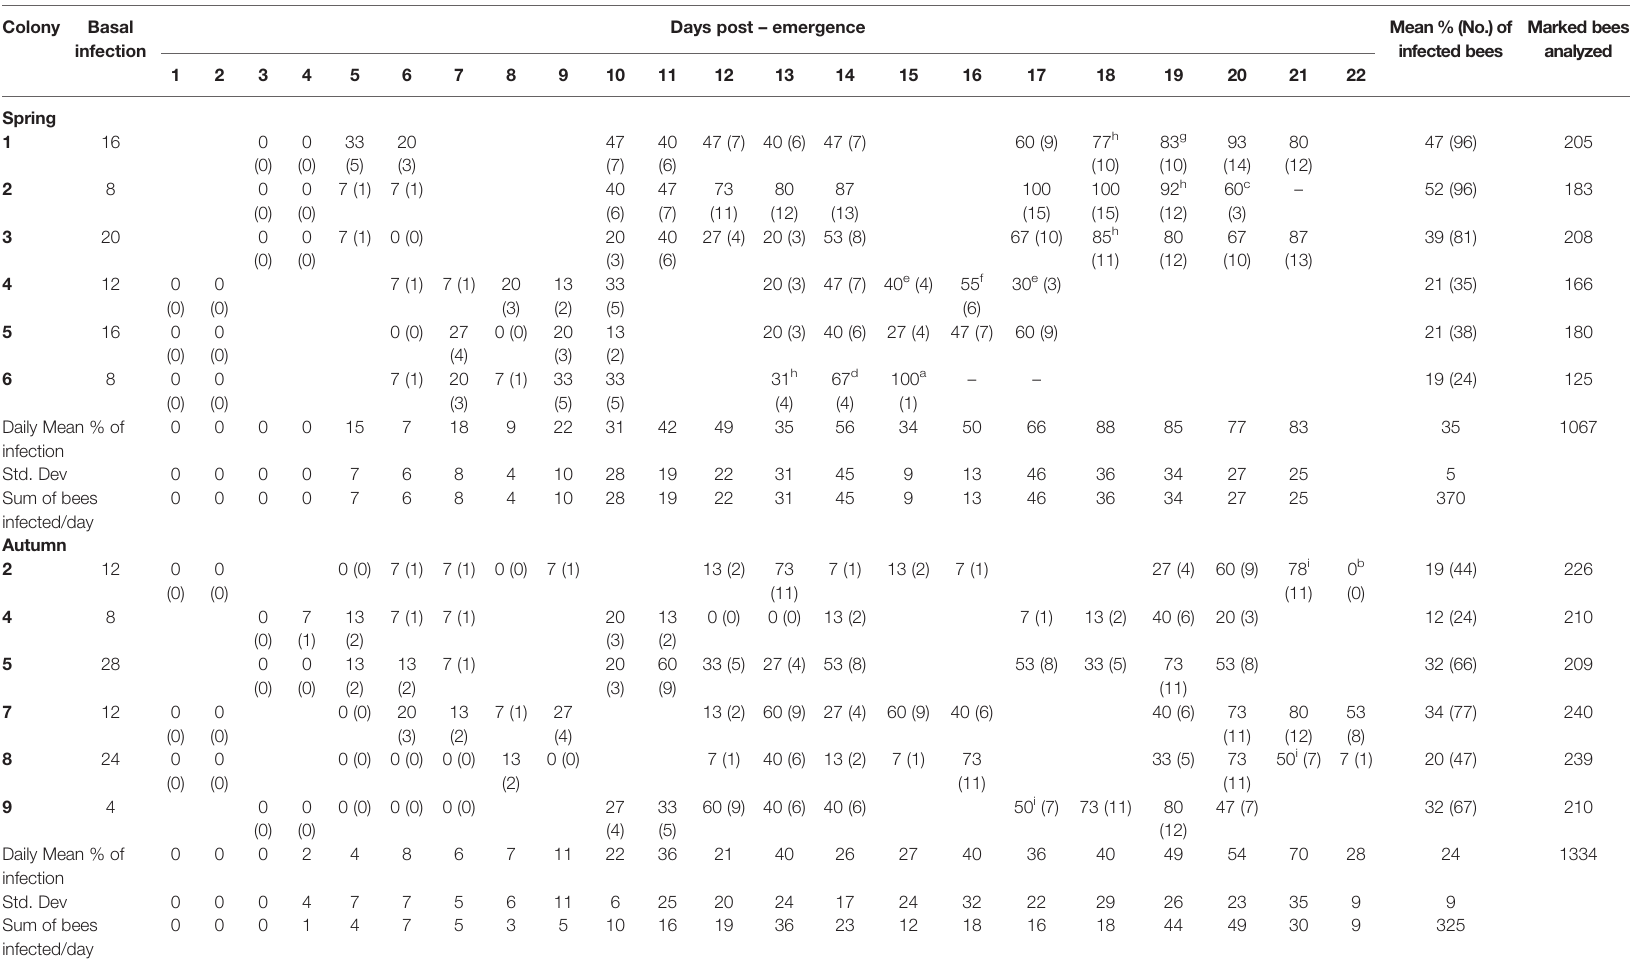
Days post – emergence Mean%(No.)of